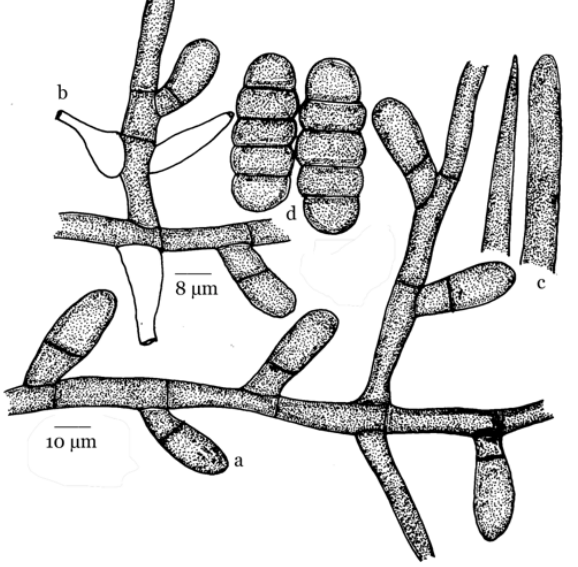
Figure 105. Meliola oligomera a - Appressorium; b - Phialide; c - Apical portion of mycelial setae; d – Ascospores